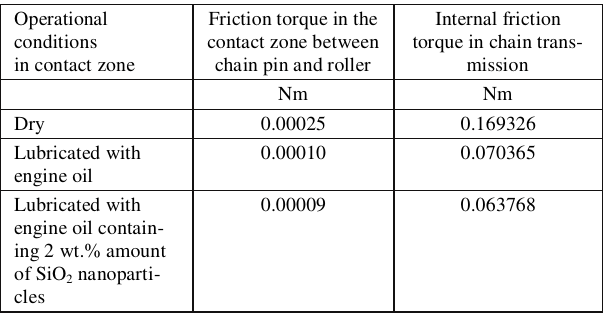
Table 3. Friction torque for different friction in the contact